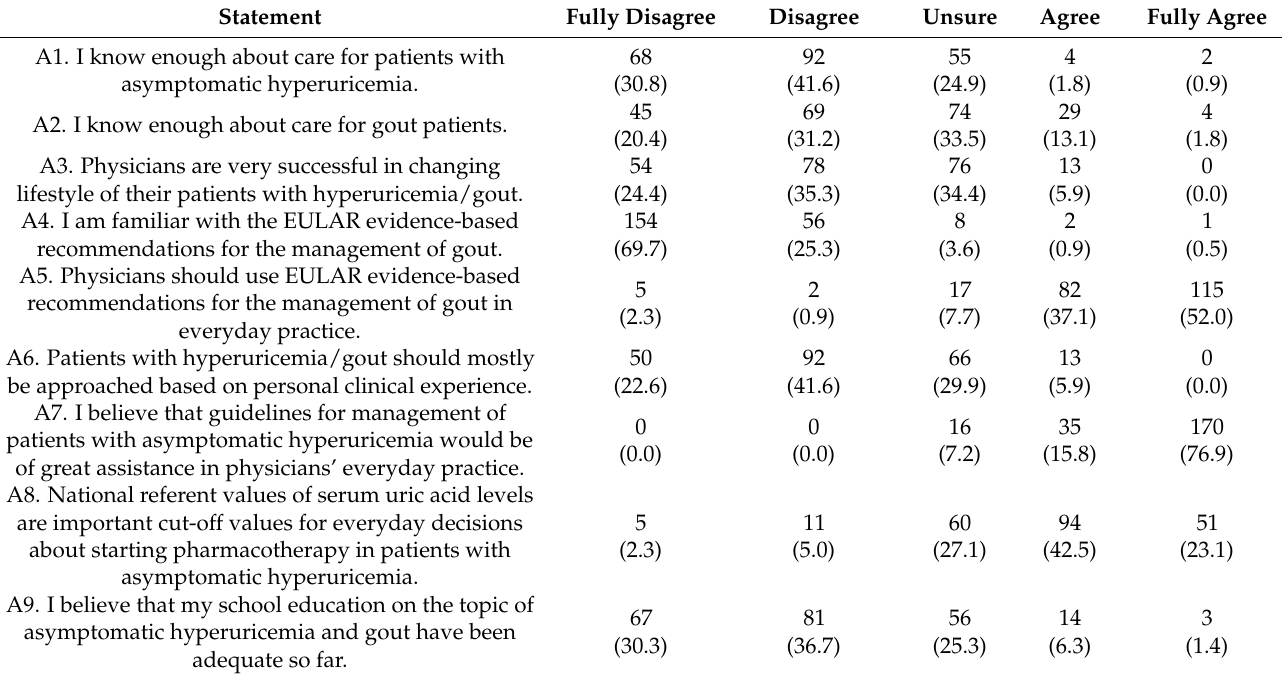
Table 4. Attitudes on management of gout and